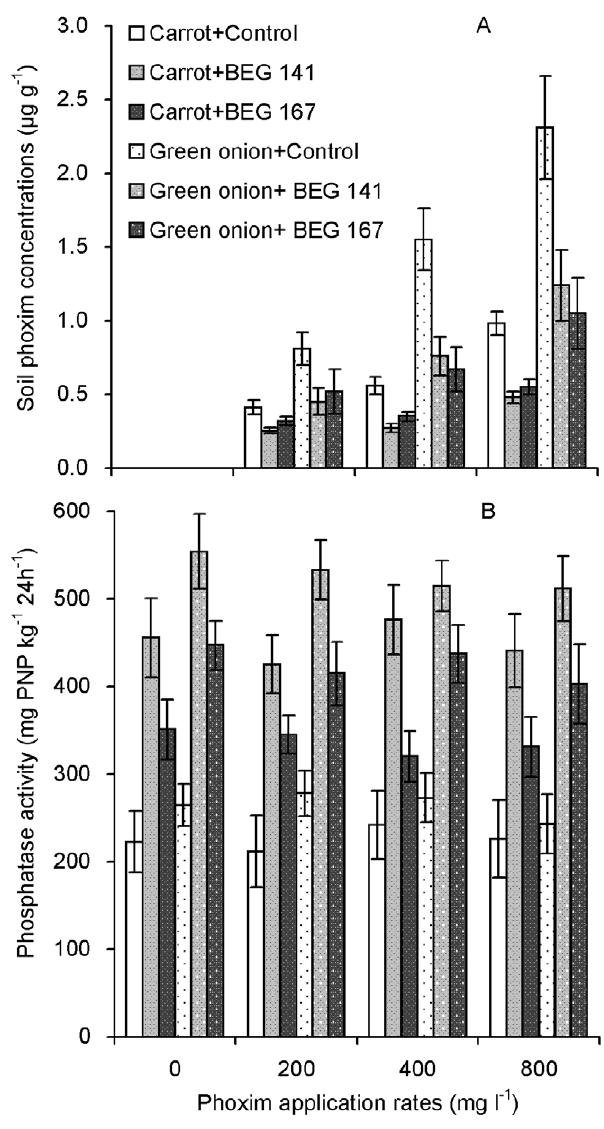
Figure 4. Soil phoxim concentrations (A) and phosphatase activity (B) (means ± SE, n =3) after carrot and green onion harvest. Control, BEG 141 and BEG 167: non-AM-inoculation, G. intraradices BEG 141 and G. mosseae BEG 167, respectively.